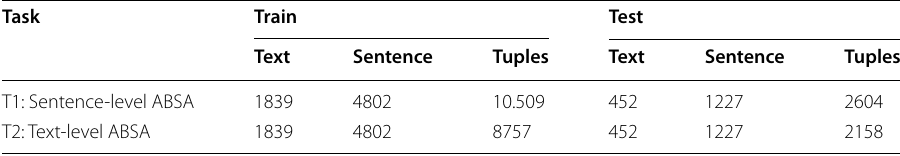
Table 2 The scale and distribution of the Arabic hotels reviews dataset